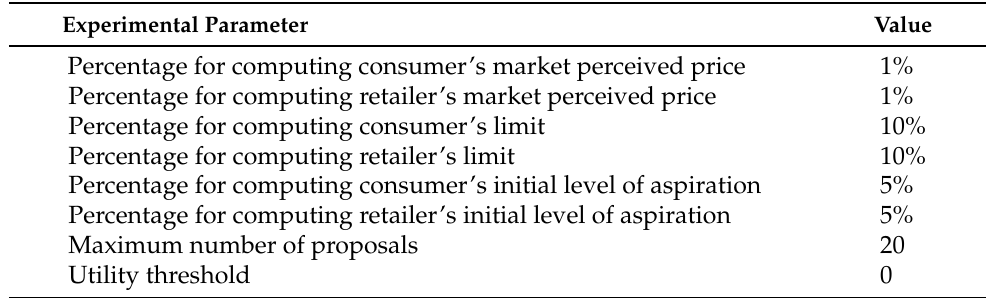
Table 1. Experimental parameter values.